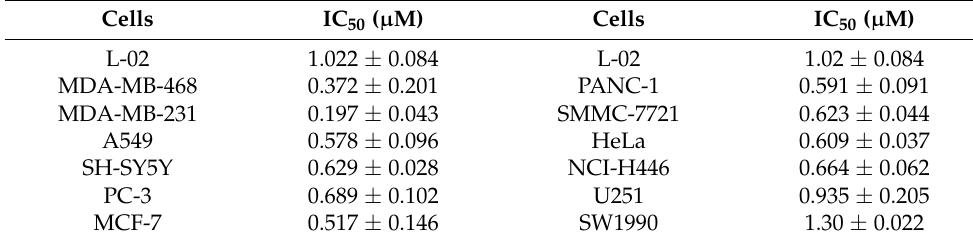
Table 1. IC 50 value of LM on multiple tumor cell lines in 48